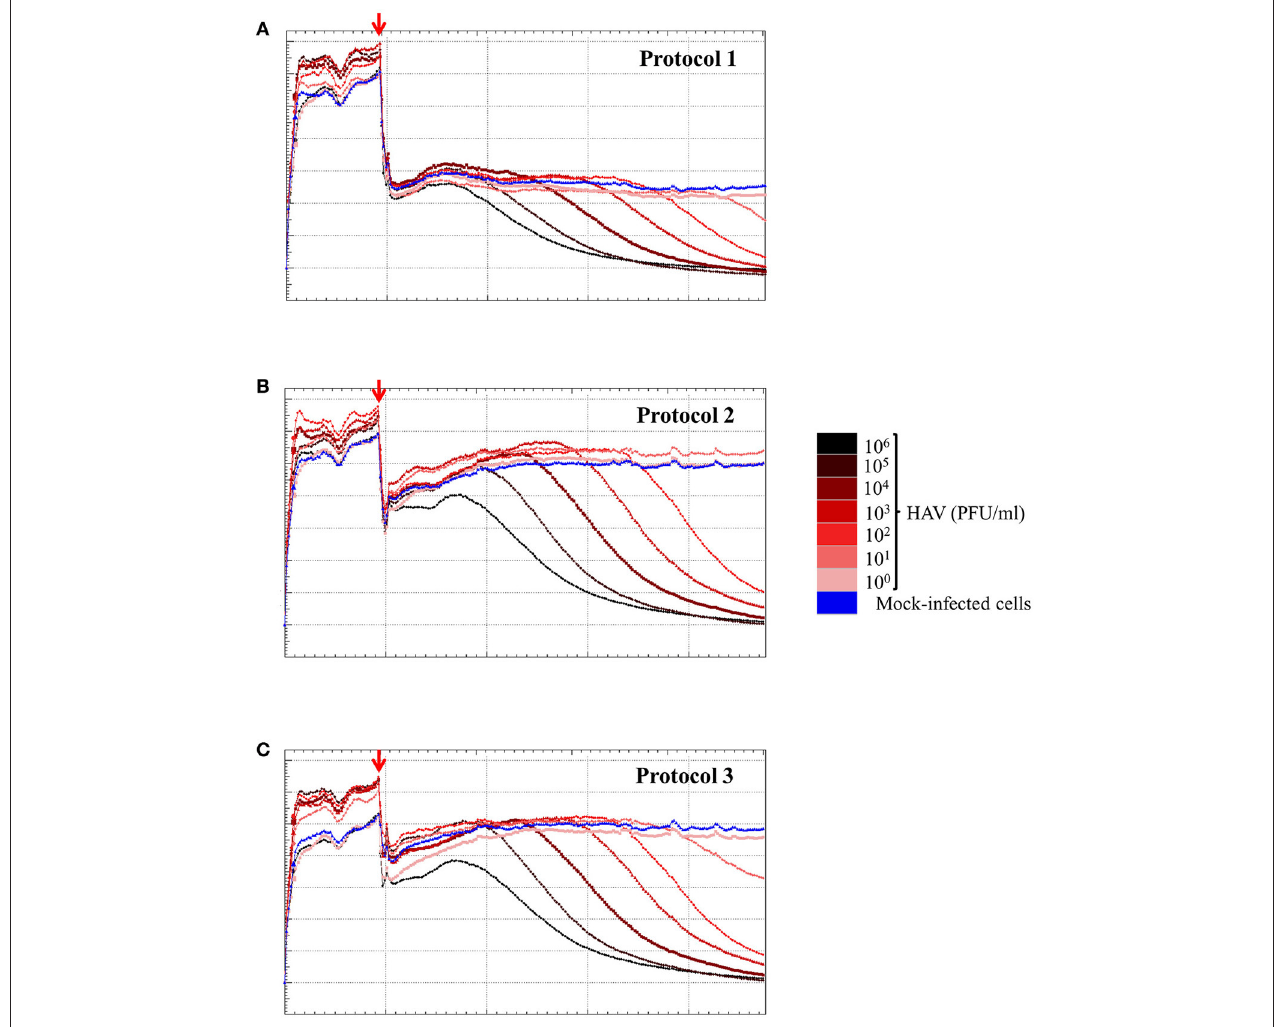
FIGURE 6 | HAV infection induces a dose-dependent effect as measured by the RTCA assay. Kinetic curves of CI values in FRhK-4 cells uninfected (blue) or infected with different amounts of HAV [from 10 5 PFU/well (black) to 0.1 PFU/well (pink)] using protocol 1 (A) , protocol 2 (B), and protocol 3 (C) . The red arrows indicate the time after which HAV was added on sub-confluent monolayers of FRhK-4